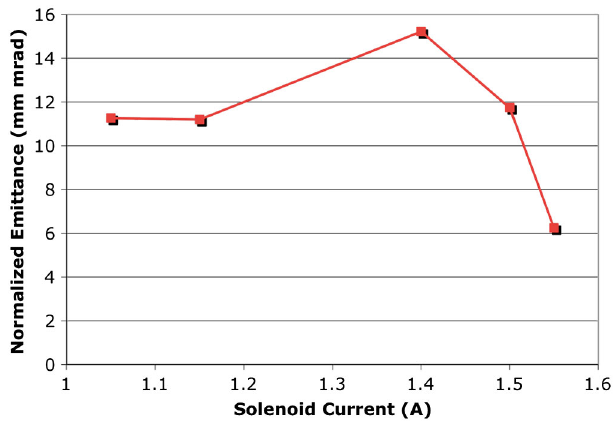
FIG. 14. Measured emittance versus solenoid current for ¼ (cid:2) 32 kV , V ¼ (cid:2) 90 V , and (cid:1) 250 W of rf drive at V cathode grid 714 MHz.